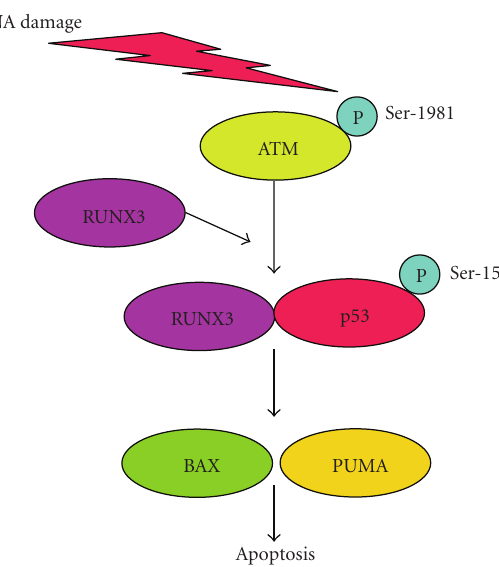
Figure 3: RUNX3 acts as a coactivator for p53 in response to DNA damage. In response to DNA damage, RUNX3 collaborates with activated form of ATM and induces phosphorylation of p53 at Ser- 15. Phosphorylated form of p53 transactivates proapoptotic BAX and PUMA .